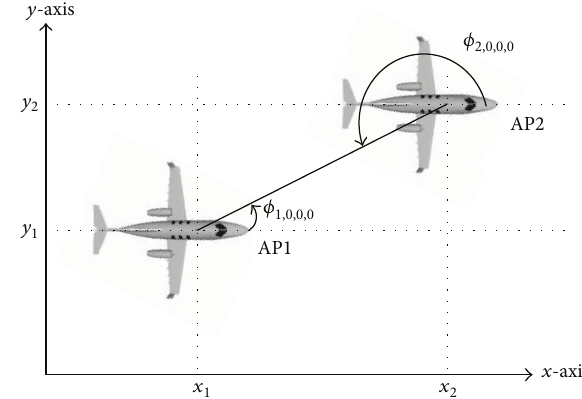
Figure 5: LOS 𝜙 1,0,0,0 and 𝜙 2,0,0,0 angle definitions for AP1 and AP2.